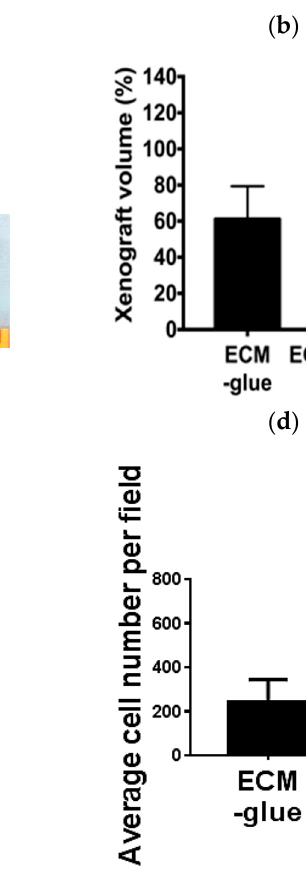
Figure 4. The xenografts composed of diced decellularized cartilage ECM and fibrin glue polymer with or without FND-labeled hASCs were transplanted subcutaneously into nude mice for three months. ( a ) Macroscopic appearance of xenografts containing ECM and fibrin glue polymer with or without FND-labeled hASCs before implantation (above) and three months afterwards (below). ( b ) Volume of the xenografts were measured. There was a statistic significant difference in the volume of xenograft between the groups of ECM-glue and ECM-hASC-glue. The values were means ± S.D. (n = 8). ** p < 0.01 versus control. Data were assessed using T tests for analysis. ( c ) Histological analysis of xenografts in both groups. Comparison of cell density by DAPI between groups of ECM-glue and ECM-hASC-glue three months afterwards (Original magnification × 400). ( d ) Cell numbers were quantified under microscope per field, as described in the Materials and Methods section, by Image J software. The ECM-hASC-glue group has significantly increased cell numbers compared to the ECM- glue group. The values were mean ± S.E.M. (n = 8). ** p < 0.01 versus control. * p < 0.05 versus control. Data were assessed using T tests for analysis. ( e ) Identification of FND-labeled hASCs in a xenograft